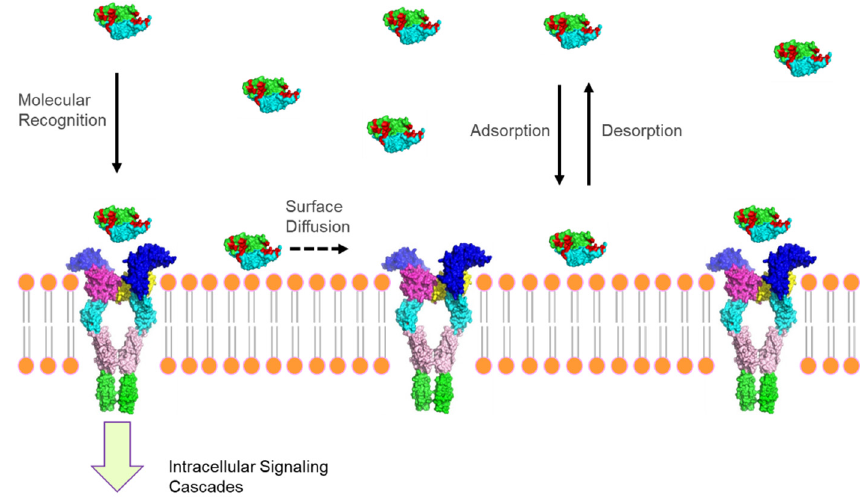
Figure 9. Interfacial phenomena involved in the molecular recognition of biomacromolecule (e.g., ligand) by transmembrane proteins (receptors) on plasma membrane. ligand) by transmembrane proteins (receptors) on plasma